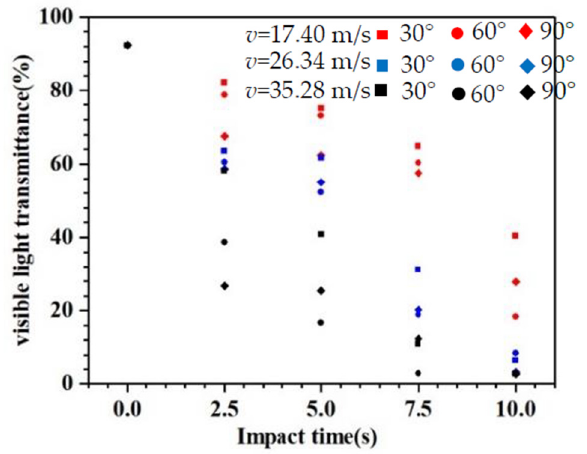
Figure 9. Visible light transmittance of the glass specimens τ v .